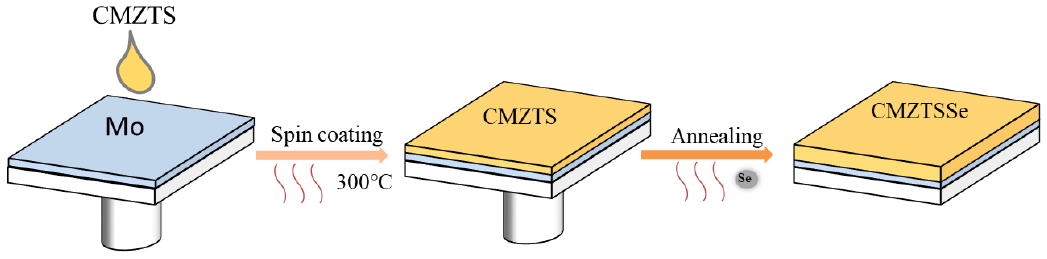
Figure 2. Schematic diagram of preparation process of CMZTSSe films.